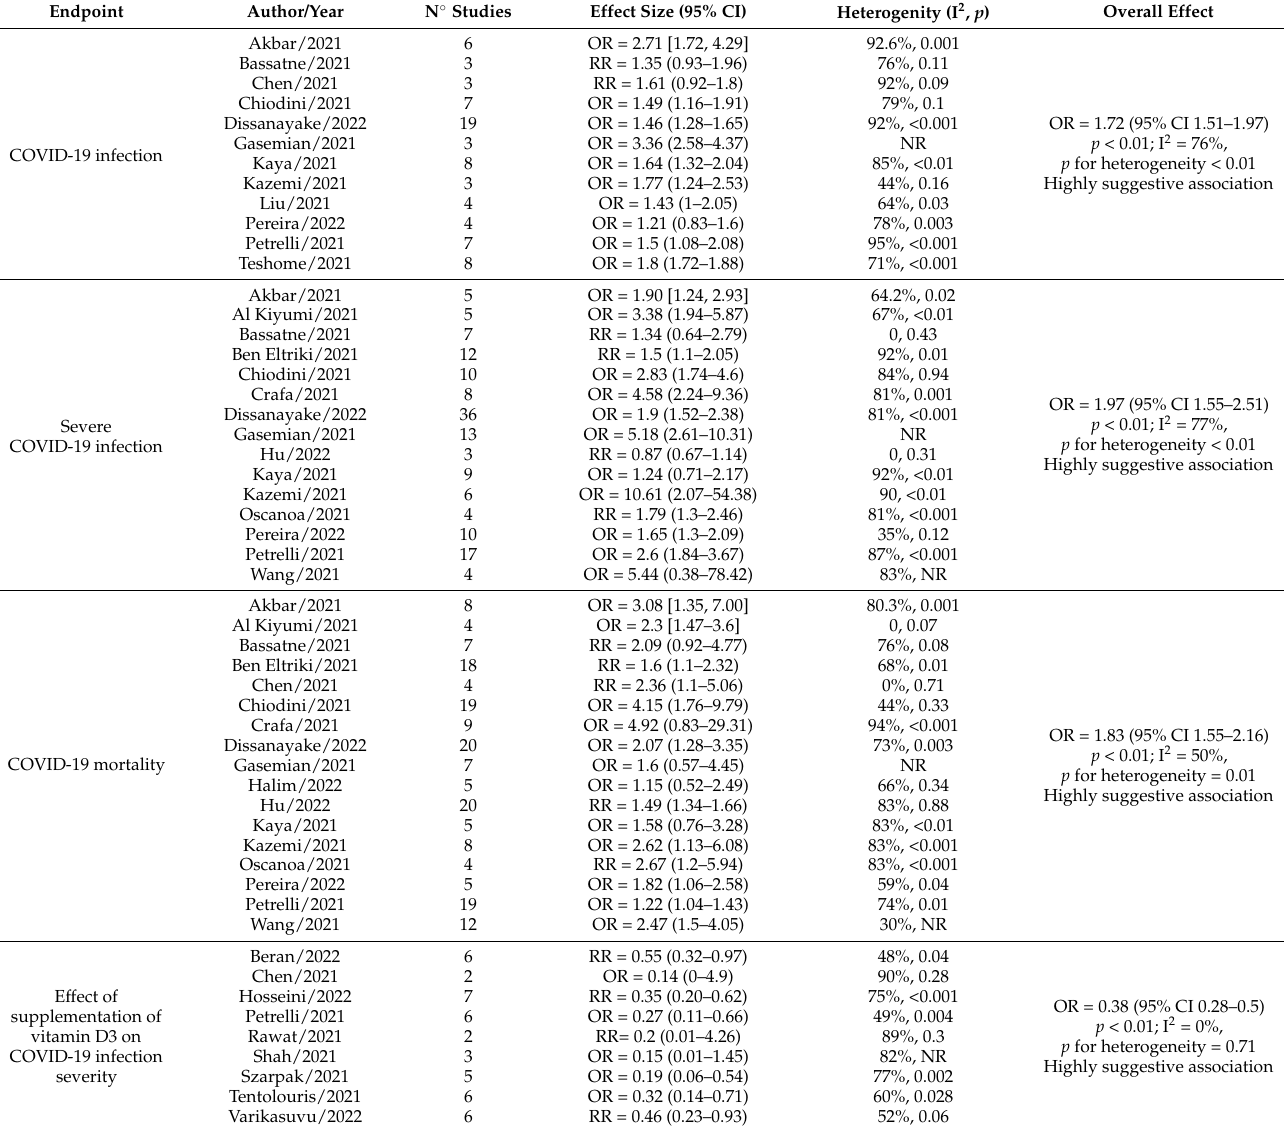
Table 2. The strength of epidemiologic evidence of the 5 unique health